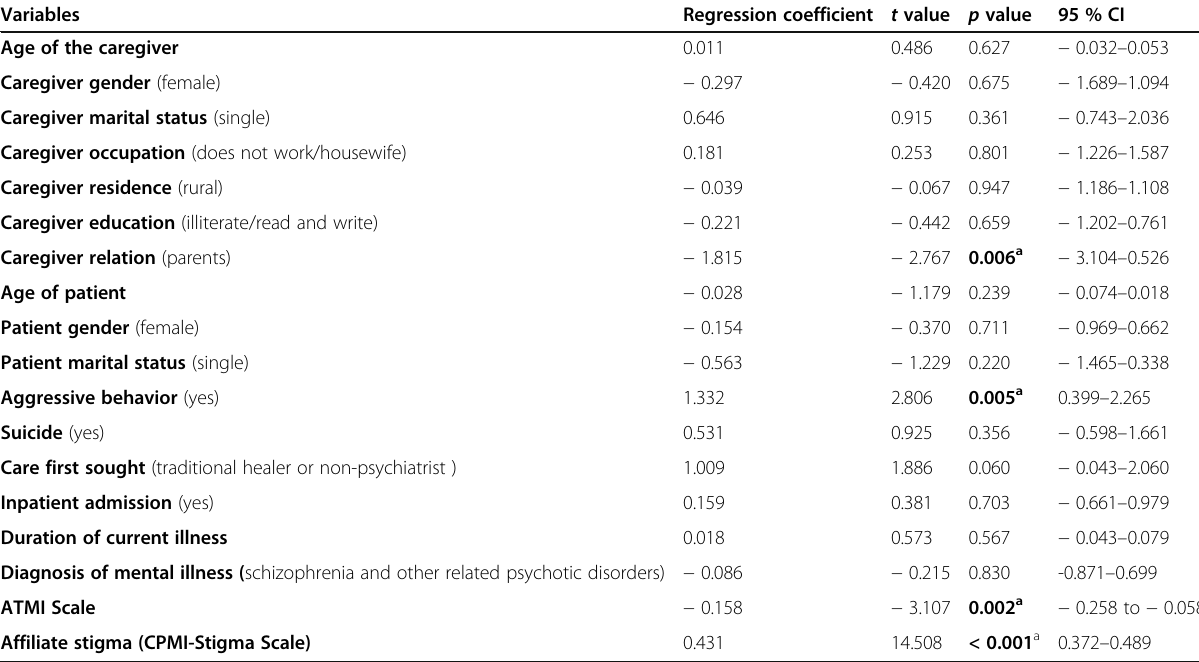
Table 5 Correlates of associate stigma among the studied participants at Assiut University Hospital, Egypt, 2017